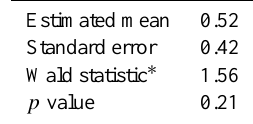
Table 7. Estimate of the mean cross-section error conditional on model